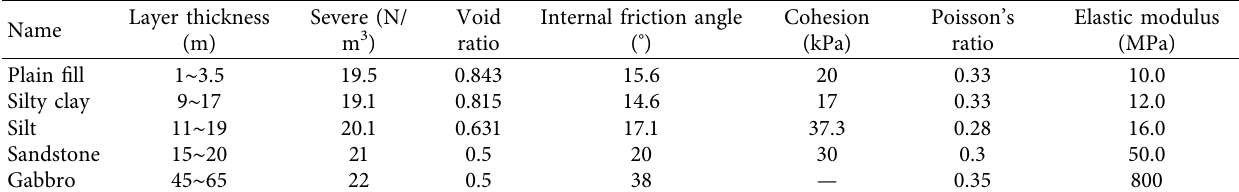
Table 2: Model calculation parameters.